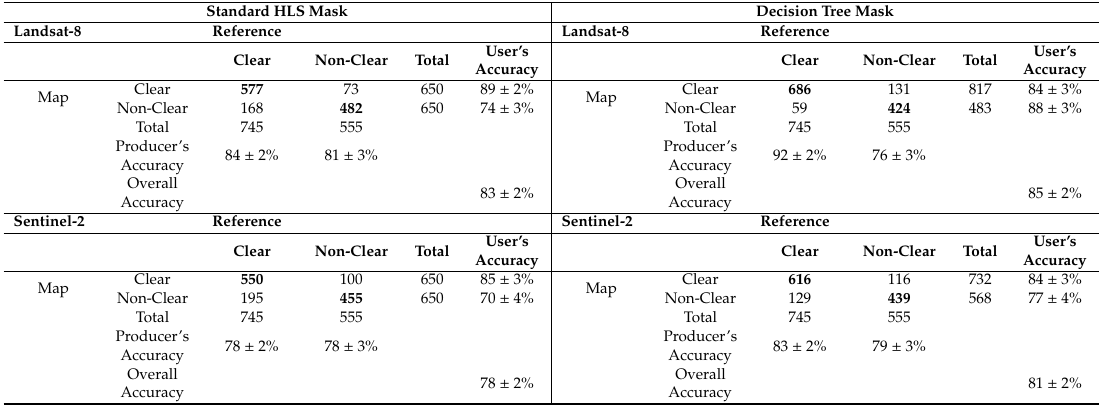
Table 1. Confusion matrices of observed and mapped values of clear and non-clear pixels (i.e., cloud, cloud shadow, water, snow / ice) in Landsat (top) and Sentinel-2A (bottom) data, as depicted by standard HLS and decision tree masks. Bold values denote correctly classified instances. Accuracy measures are presented with 95% confidence